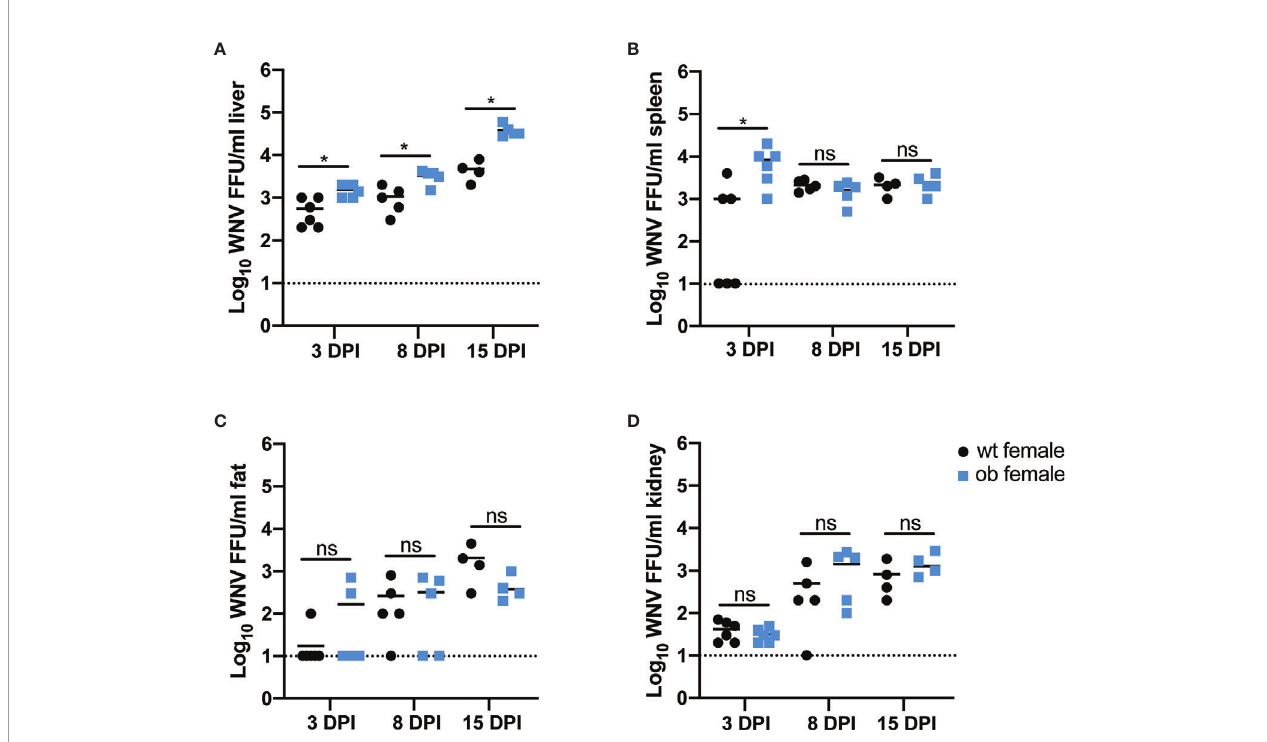
FIGURE 3 | The obese state in females promotes early WNV entry into peripheral organs. (A – D) Infectious viral titers in female mouse organs. Mice were infected with 100 FFU of WNV via subcutaneous foot pad injection. At 3 (wt n=6 and ob n=6), 8 (wt n=5 and ob n=5) or 15 (wt n=4 and ob n=4) days post infection, liver (A) , spleen (B) , fat (C) and kidney (D) were harvested, frozen and homogenized. Levels of infectious virus were measured via focus forming assay and reported as FFU/ ml of organ homogenate. Asterisks indicate statistically signi fi cant values (*p < 0.05) as determined by Mann-Whitney test. ns, not signi fi